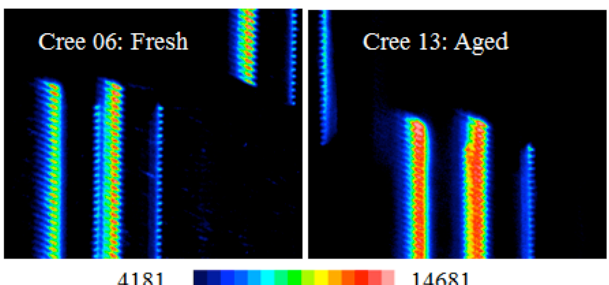
Fig. 9 Spectral PEM analysis of the fresh and the aged devices